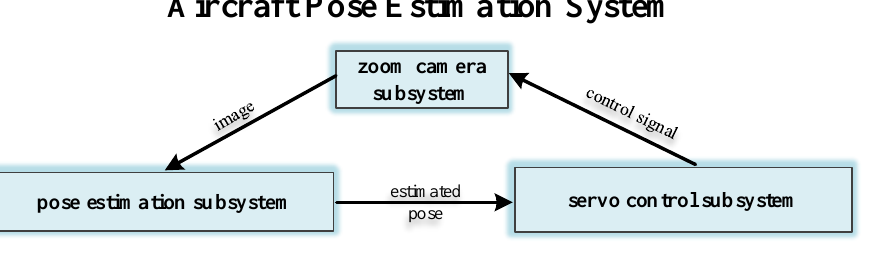
Figure 1. Illustration of the aircraft pose estimation system. This system consists of three parts: the zoom camera subsystem, the pose estimation subsystem, and the servo control subsystem. The zoom camera system is used to capture the 2D image. The pose estimation subsystem is used to estimate the 6D pose parameter. The servo control subsystem is used to control the zoom camera subsystem.